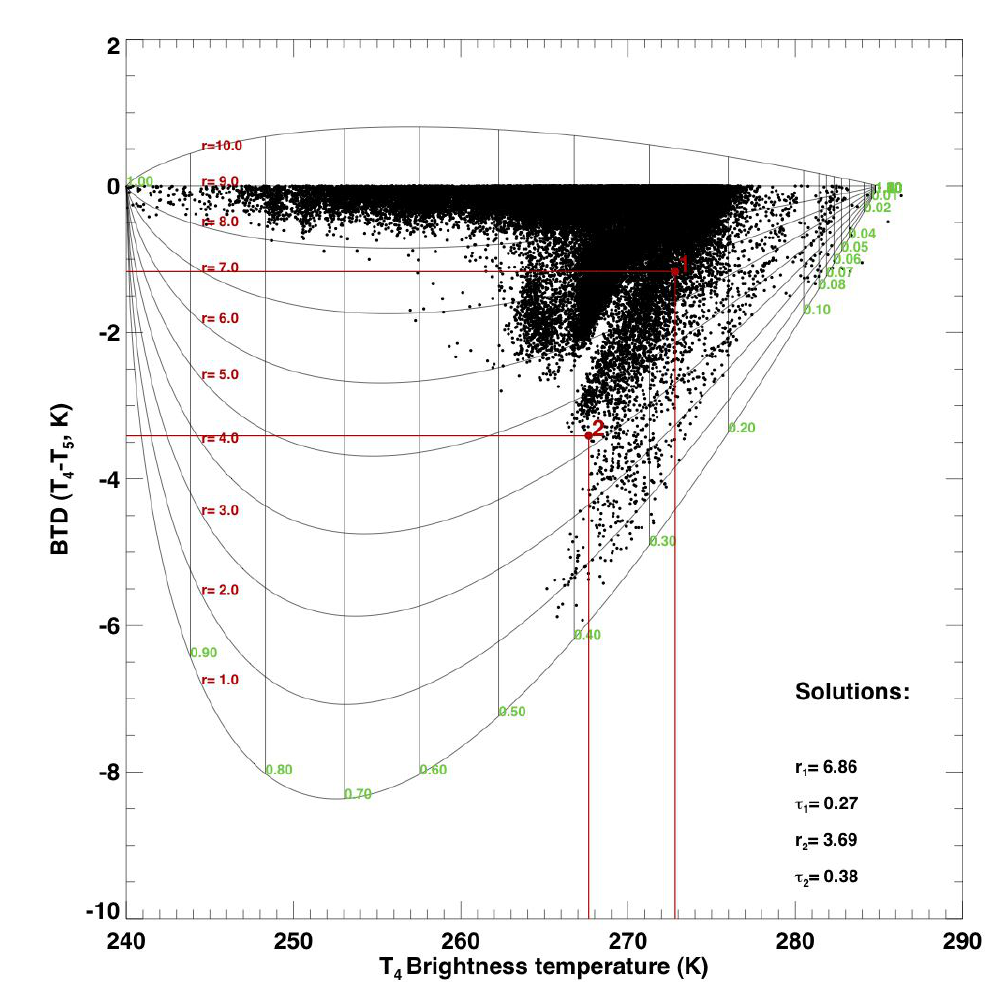
Figure 4. Illustration of the relation between the retrieved quantities r , the effective particle radius, τ the optical depth and brightness temperatures. The black dots are data points. The nearly vertical lines are isolines of optical depth (green) and the curves correspond to different effective